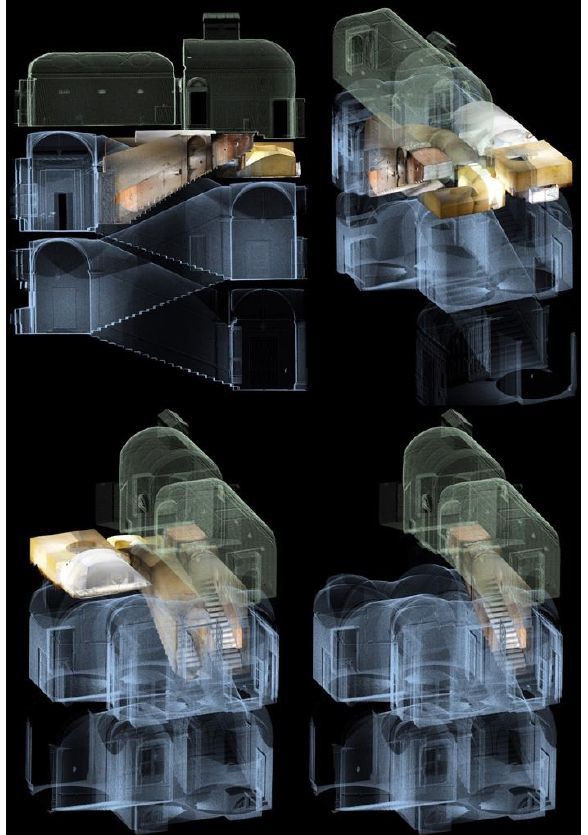
Figure 4. The point cloud treated with different colors and densities to build a special three-dimensional model.